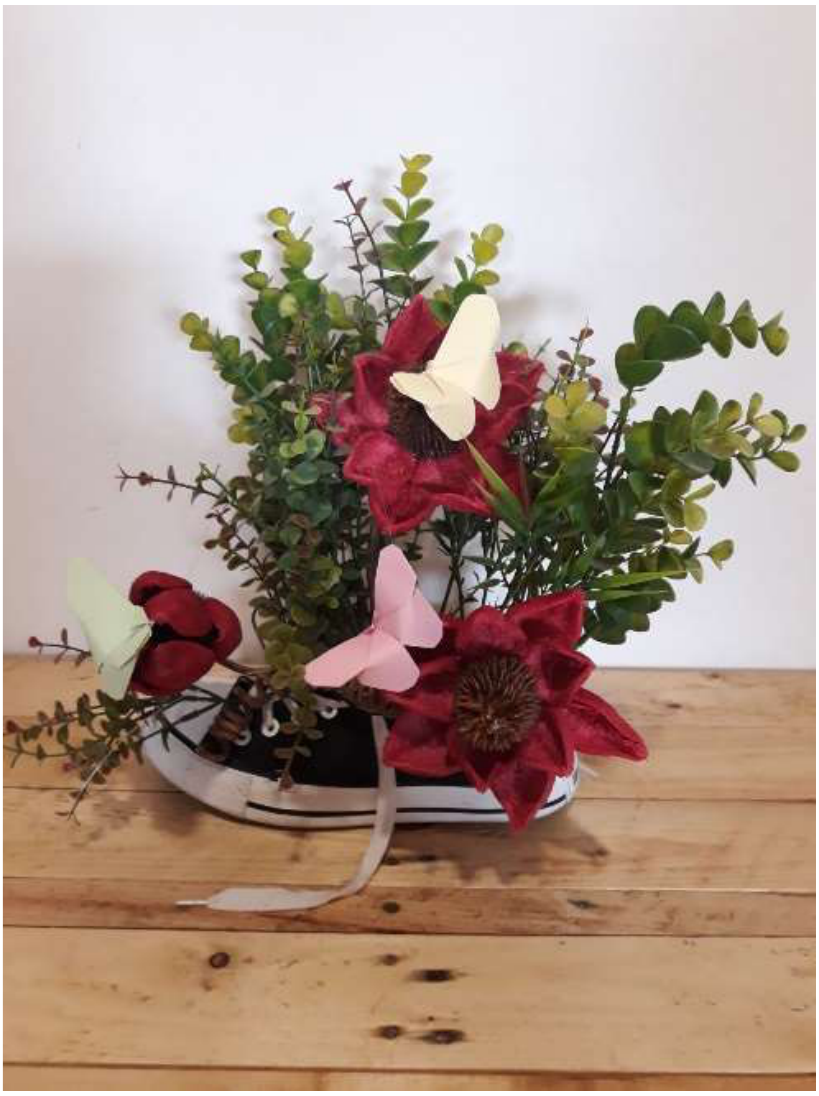
Figure 4. Spring. Photography (INCRU).